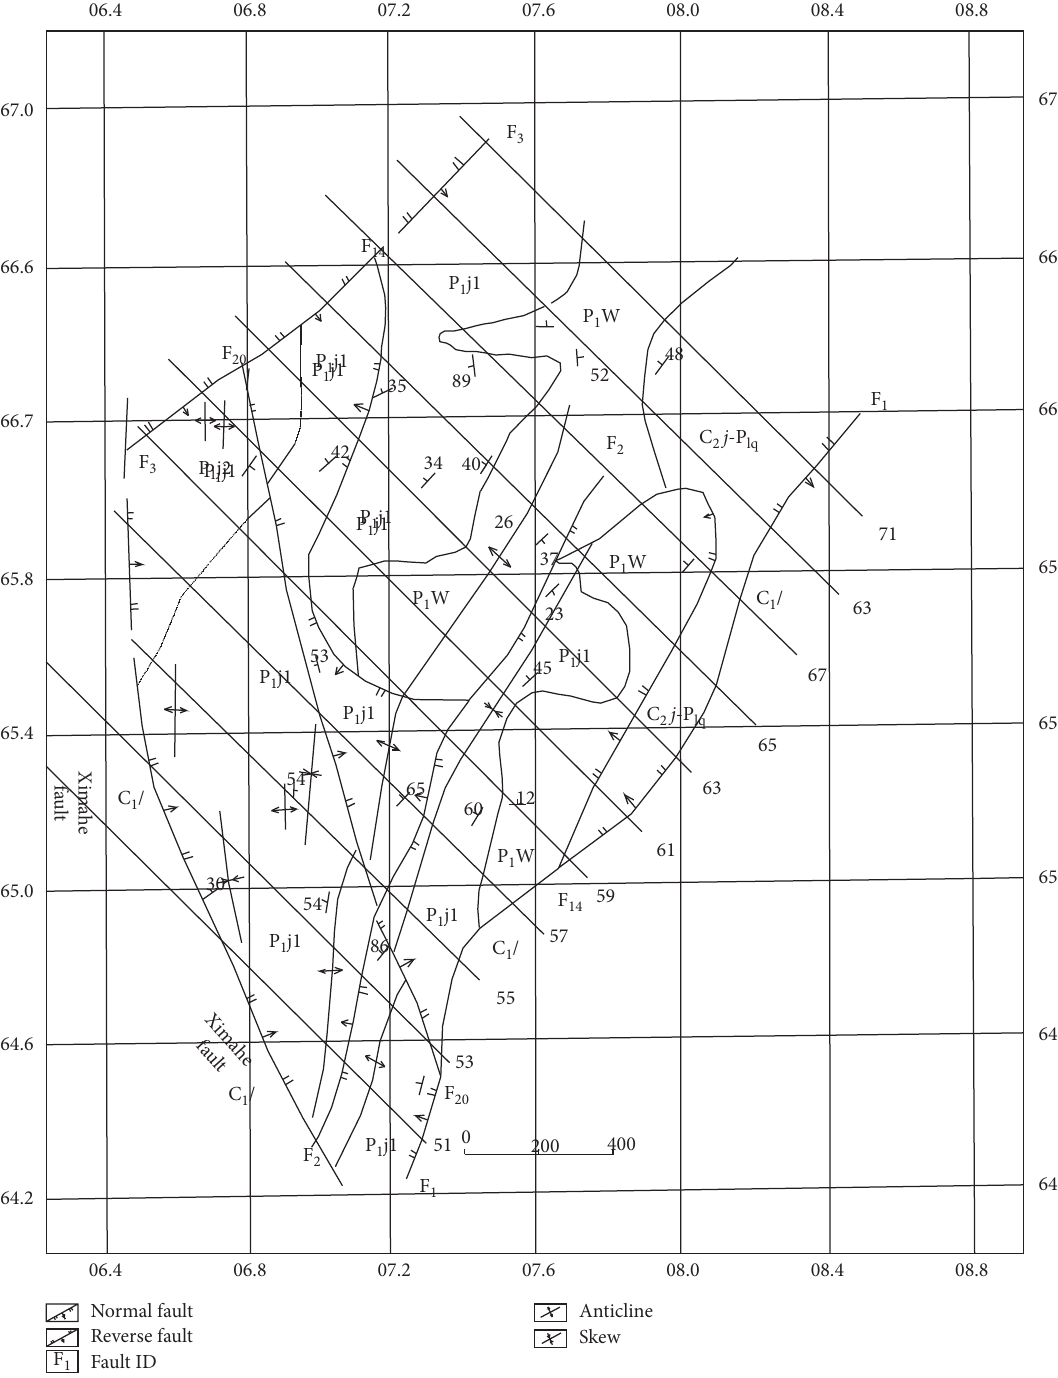
Figure 3: Geological map of the Makeng Iron